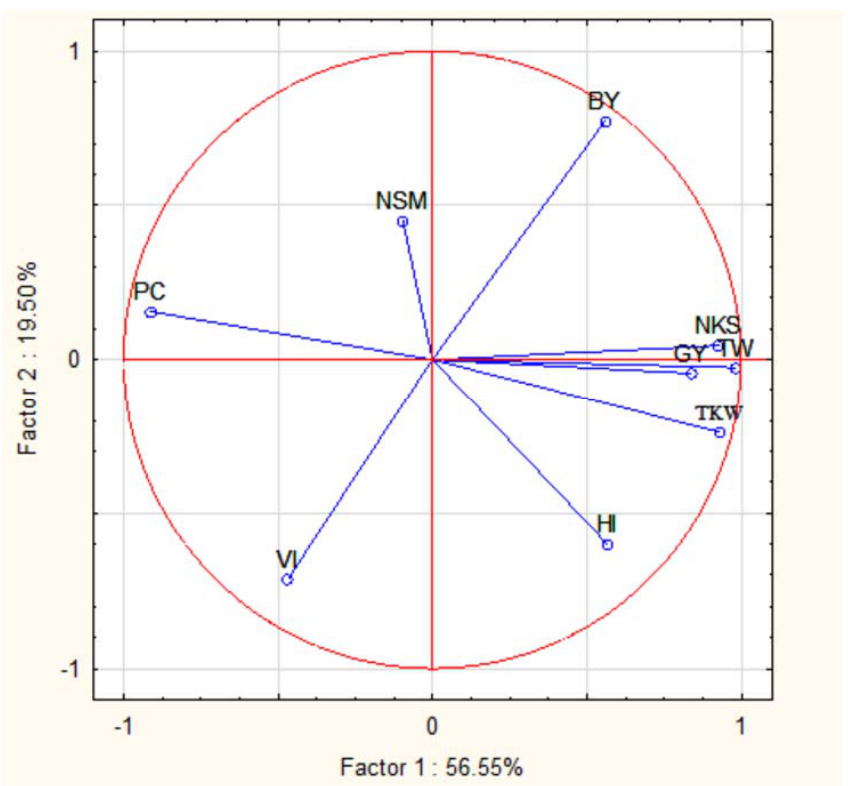
Figure 1. Projection of the variables on the factor plan (1–2). Please note: GY: Grain yield; BY: Biomass yield; HI: Harvest index; NSM: Number of spikes per square meter; NKS: Number of kernels per spike; TW: Test weight; TKW: Thousand kernel weight; PC: Protein content; VI: Grain vitreosity.